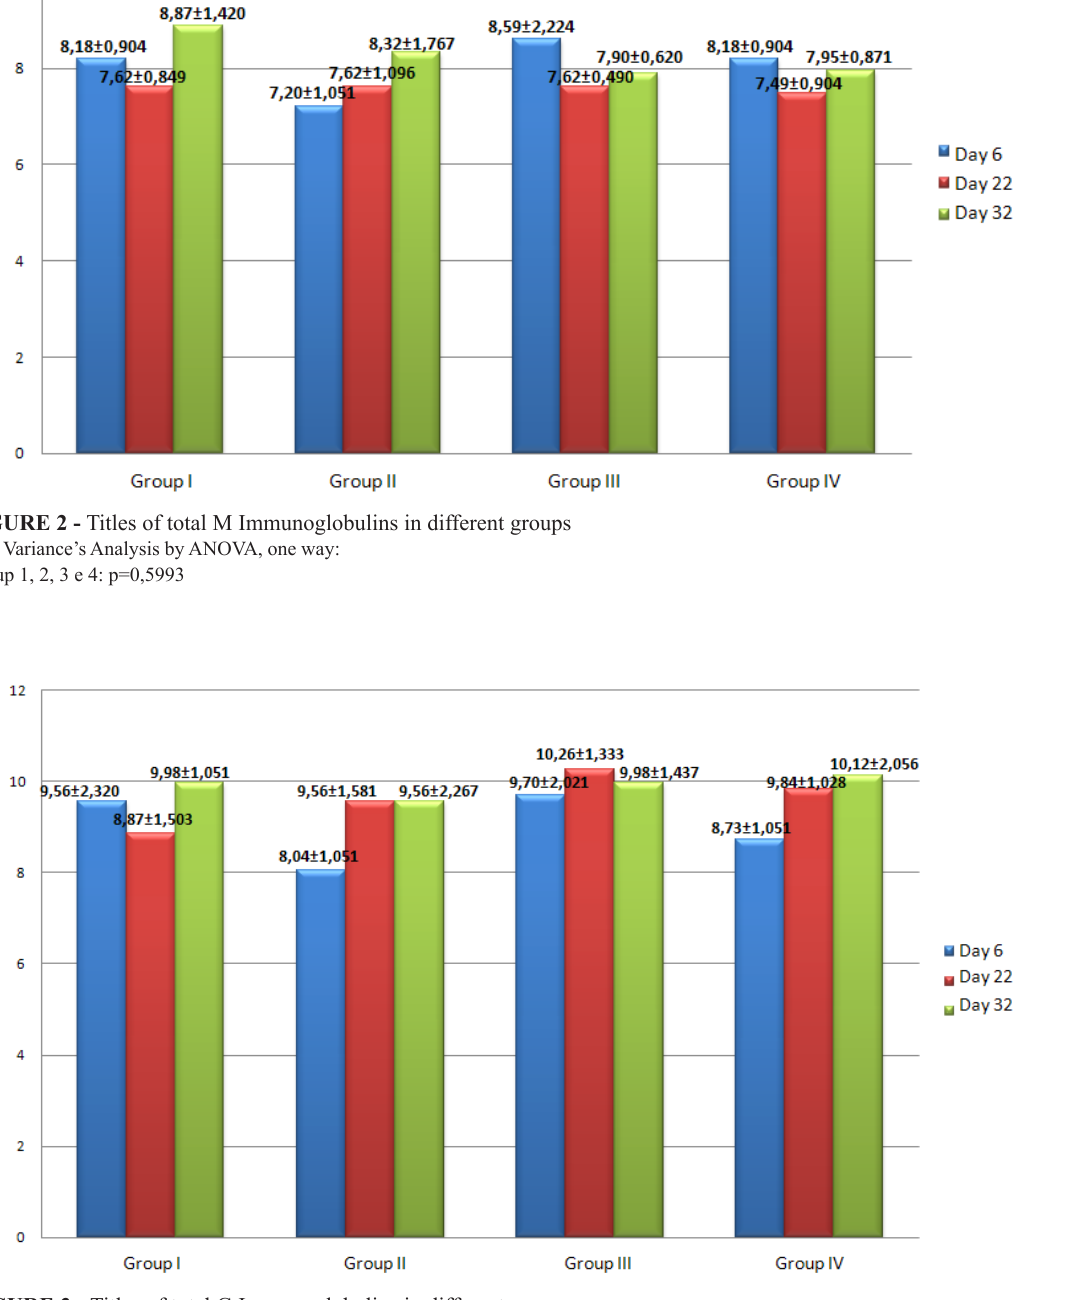
FIGURE 3 - Titles of total G Immunoglobulins in different groups P.S.: Variance’s Analysis by ANOVA, one way: Group 1, 2, 3 e 4: